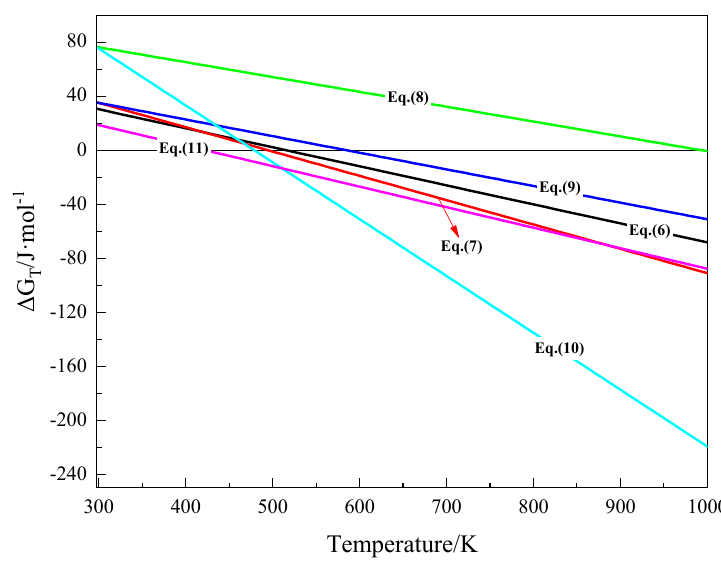
Figure 9. Reaction ∆ G T – T diagrams in the system with the addition of NaOH. Figure 9. Reaction Δ G T –T diagrams in the system with the addition of NaOH.